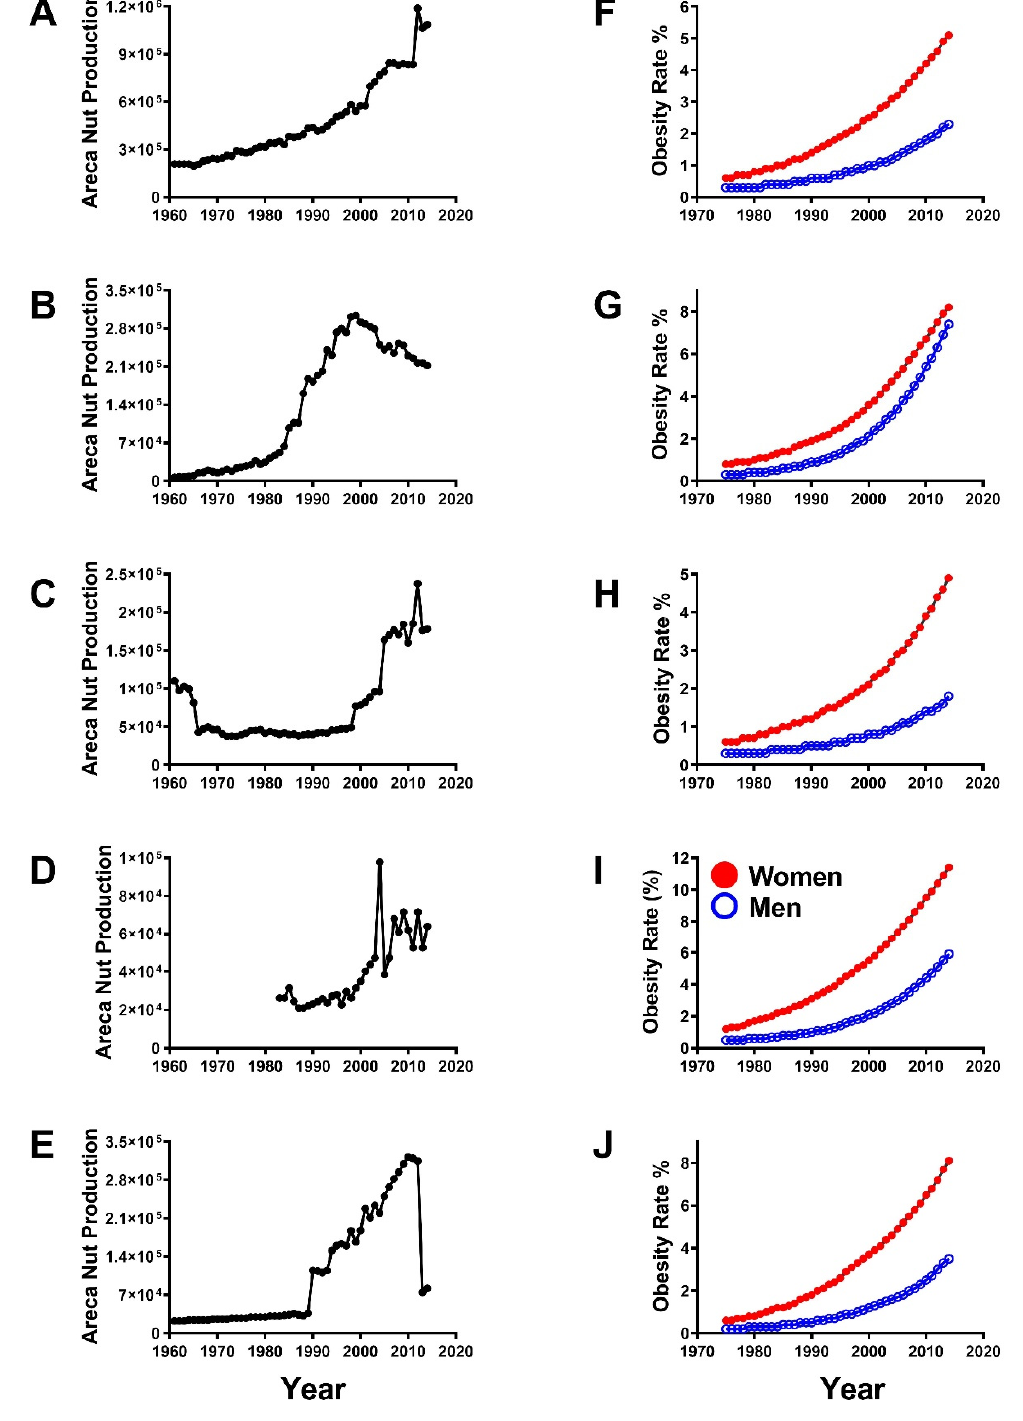
Figure 1. Comparisons of time-dependent increases in ( A – E ) areca nut production (gross production value constant 1000 1$) and ( F – J ) obesity rates among women (red) and men (blue) in ( A , F ) India, ( B , G ) China, ( C , H ) Bangladesh, ( D , I ) Thailand, and ( E , J ) Indonesia. Year over year data were extracted from the Food and Agricultural Organization of the United Nations website.